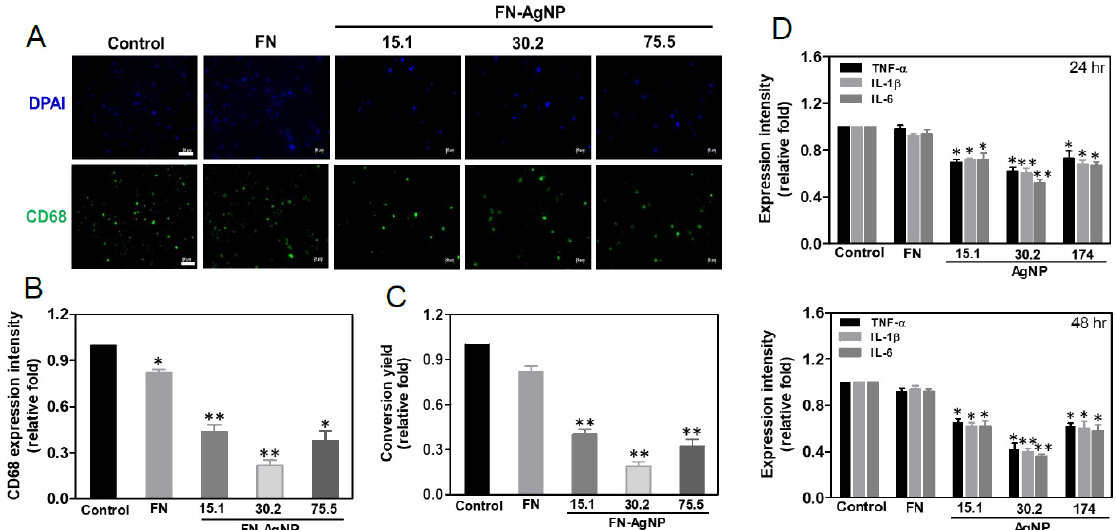
Figure 3. CD68 expression of macrophages on various materials at 96 h and the expression of pro-inflammatory cytokines (TNF- α , IL-1 β , IL-6) at 24 and 48 h. ( A ) The cells were stained by primary anti-CD68 antibody and conjugated with FITC-immunoglobin secondary antibody (green color). DAPI solution was used to locate cell nuclei (blue color). The results were captured using fluorescence microscopy. Scale bar = 20 µ m. ( B ) The expression level of CD68 was analyzed based on fluorescence intensity. ( C ) The conversion yield of human monocytes activation after culturing on pure FN and various concentrations of FN-AgNP for 96 h. ( D ) The expression of proinflammatory cytokines at 24 and 48 h was analyzed based on the expression intensity. Data are the mean ± SD ( n = 3). * p < 0.05; ** p < 0.01: smaller than the control. Control group = glass cover